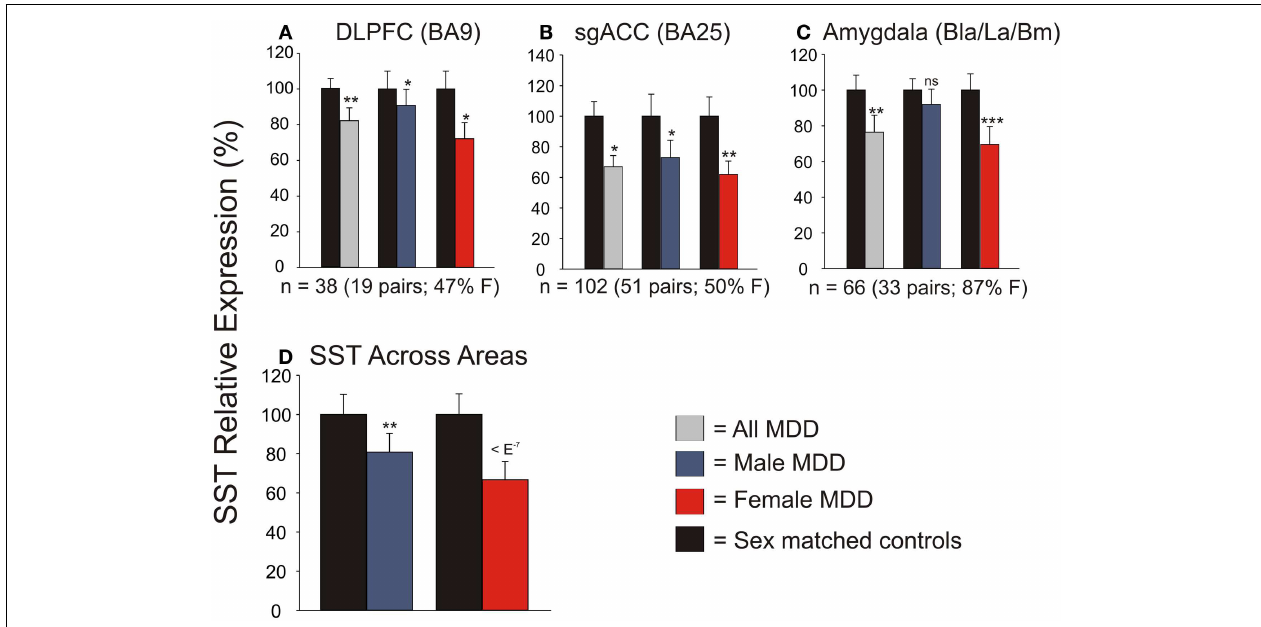
FIGURE 3 | qPCR validation of microarray meta-analysis . Individual qPCR results in the dorsolateral prefrontal cortex (DLPFC) (A) , subgenual anterior cingulate cortex (B) , and amygdala (C) . (D) When individual qPCR results are combined by meta-analysis, females have a much more robust down-regulation of SST expression than males. * p < 0.05; ** p < 0.01; *** p < 0.001; ns, not